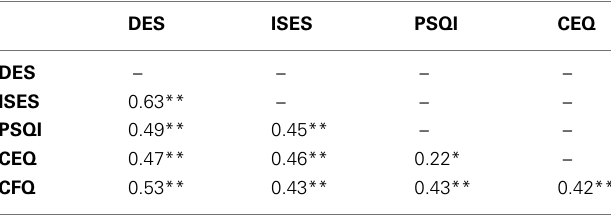
Table 2 | Pearson product moment partial correlations between baseline measures ( N = 94), controlling for years of education